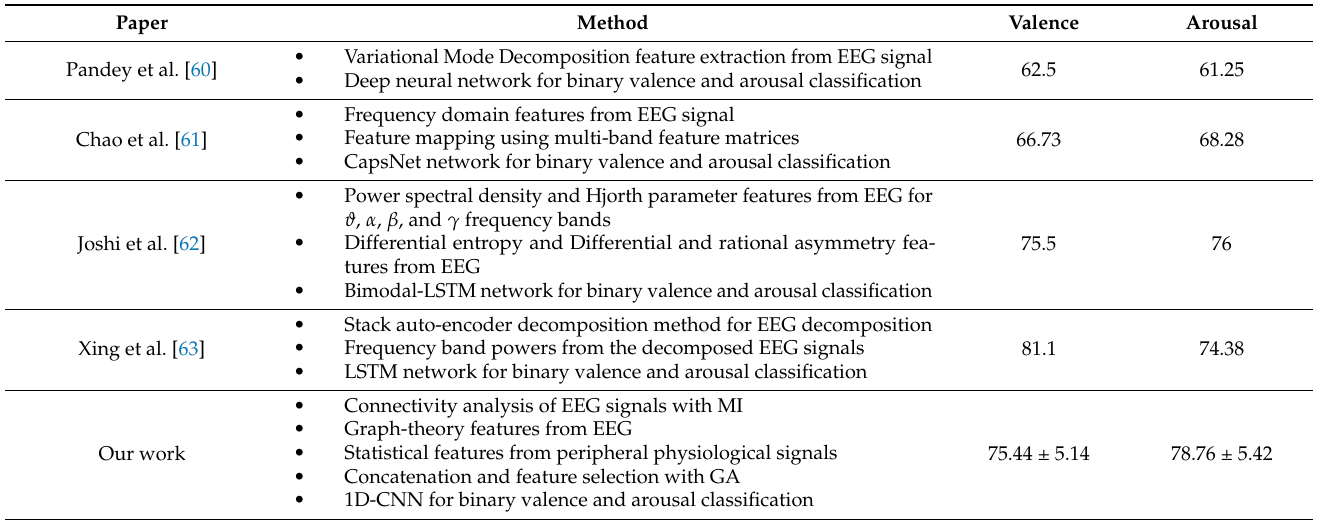
Table 6. Comparison of our accuracy results with other state-of-the-art methods using subject- independent models. In the second column, the method used for the valence and arousal classification is presented. The last two columns refer to the best accuracy results (mean ± standard deviation) for the valence and arousal